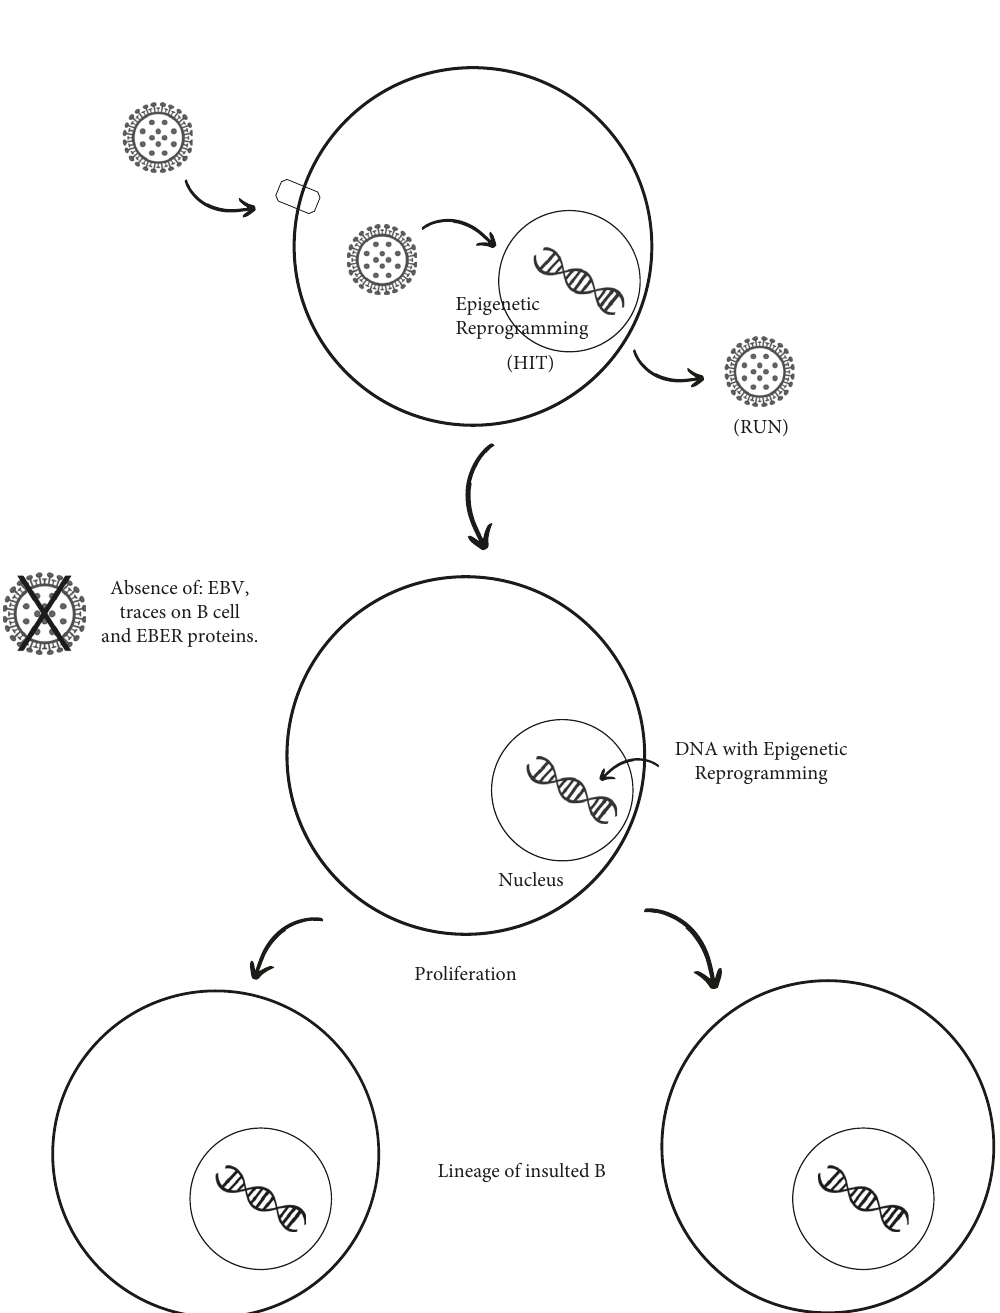
Figure 3: EBV enters the B lymphocyte, causing a series of changes in DNA expression. Following the insult, epigenetic changes and silencing of genes expressing viral antigens occur in the host lymphocyte. Subsequently, EBV disappears completely from the insulted cell, and a process of B-cell proliferation begins in the same cell. In this manner, the daughter cells inherit the DNA reprogrammed by EBV, without the virus being present in the proliferation